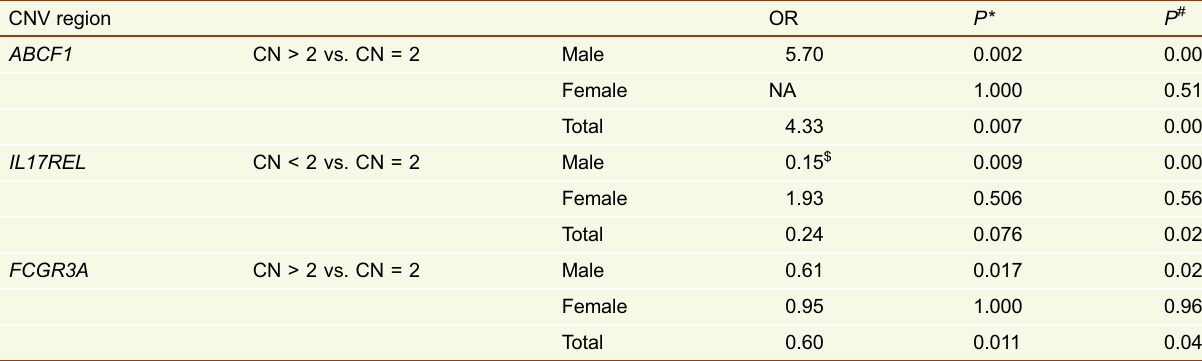
Table 1. Copy number variants in genes in fl uenced the risk of gout CNV